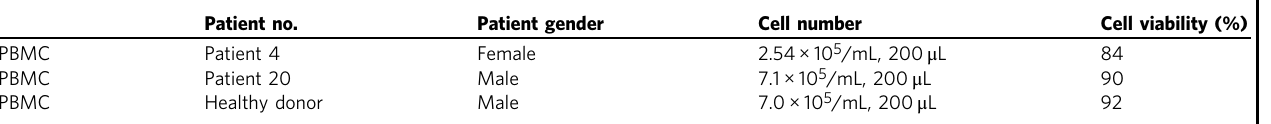
Table 1 Patient sample information for